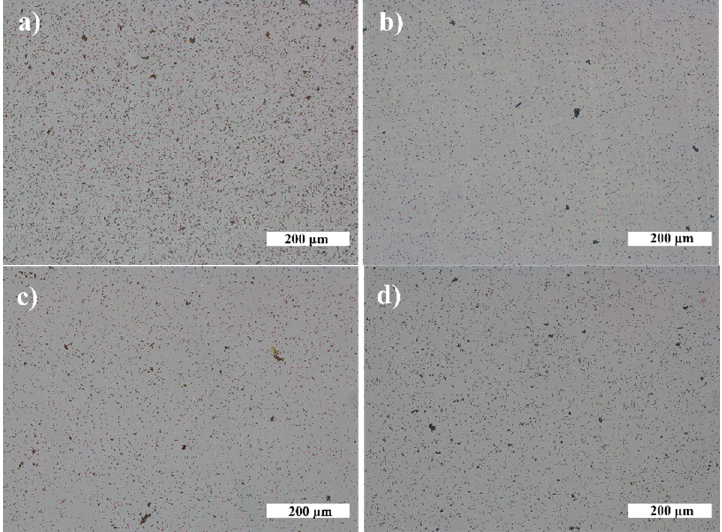
Figure 12. V. parvula biofilms on NP (magnification ×10): ( a ) TiO 2 —20 °C, AgNP; ( b ) TiO 2 —20 °C, AuNP; ( c ) TiO 2 —500 °C, AgNP; and ( d ) TiO 2 —500 °C, AuNP. The best antibacterial properties are for the samples having 82.8 μm −2 density of AuNP and 64.6 μm −2 density of AgNP. In comparison, the antibacterial properties describ- ing parameters were very close for 85.8 μm −2 density of AgNP sample (Table 2).